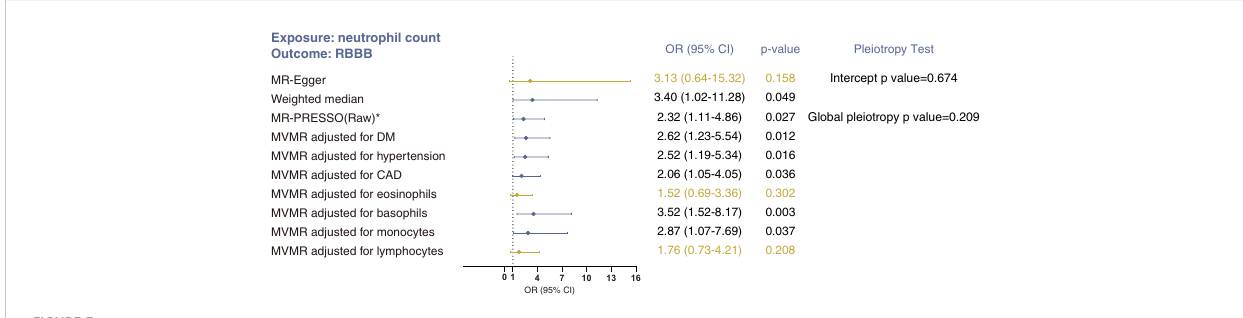
FIGURE 3 Sensitivity analyses of the causal association between neutrophil count and risk of RBBB using MR-Egger, weighted median, MR-PRESSO and MVMR analyses. *No outlier was detected. Statistical signi fi cance was de fi ned as